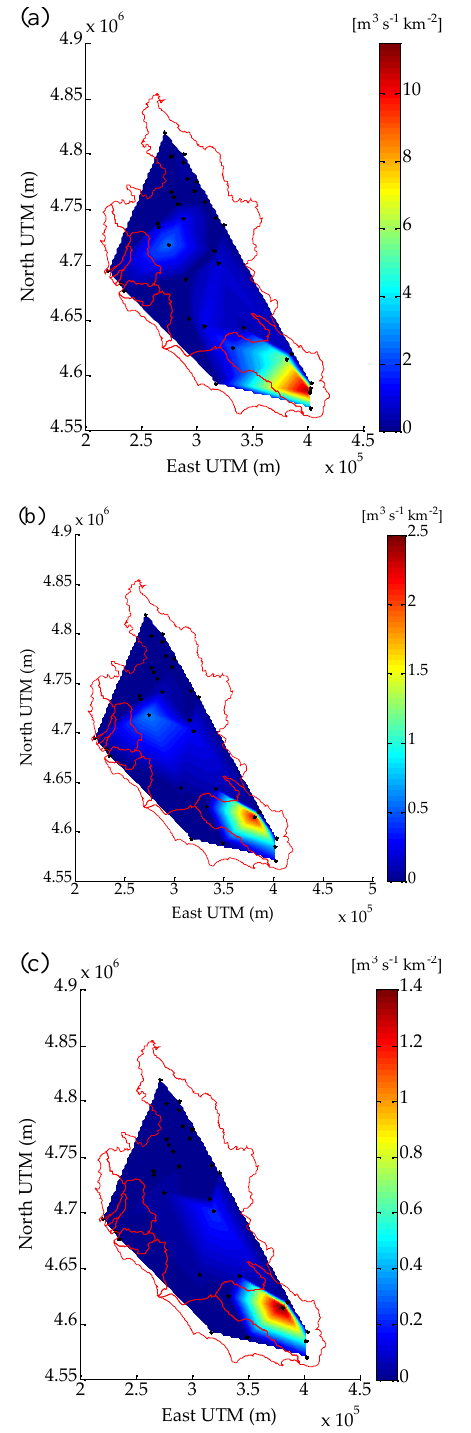
Fig. 2. Geographical representation of specific quantiles q 1 (a) , q 50 (b) and q 95 (c) . The biggest values of quantiles are located in the Southeast (Apenninic area), and the dimension of the region of interest decreases from higher (q 1 ) to lower quantiles (q 95 ). The black points in the figures represent the gauge stations in the study region.